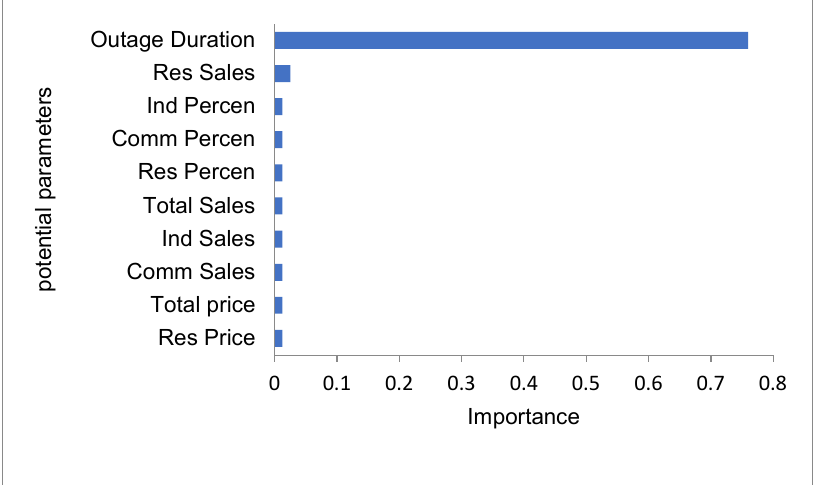
Figure 18. Ranking of top 10 important parameters for revenue loss prediction for the thunderstorm disaster category.